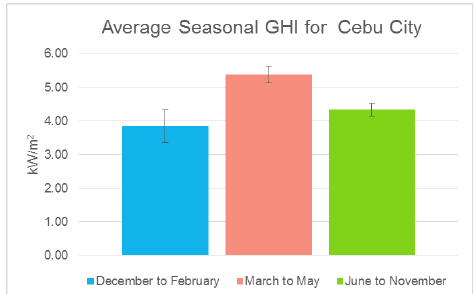
Figure 6. Average and standard deviation of